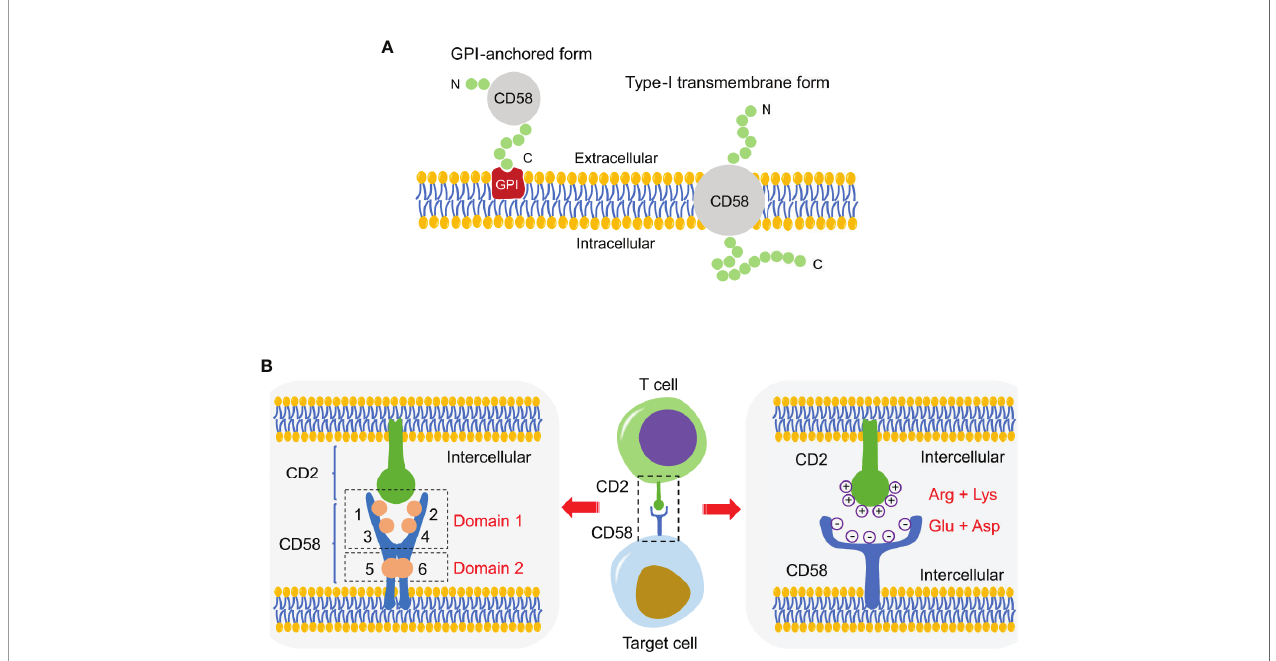
FIGURE 2 | Schematic of CD58 isoforms and CD2-CD58 interface. (A) Schematic diagram of two CD58 isoforms, a GPI-anchored and a type-I transmembrane form. (B) Structure diagram of the interface in CD2-CD58, which is mainly supported by electrostatic complementarity instead of shape